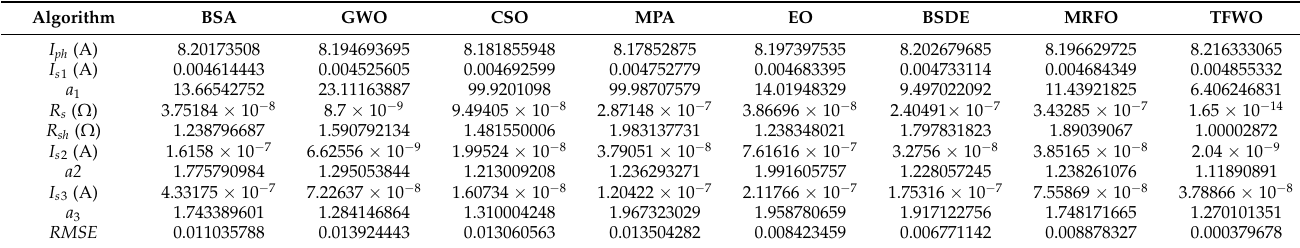
Table 11. Extracted parameters for KC200GT TDM.